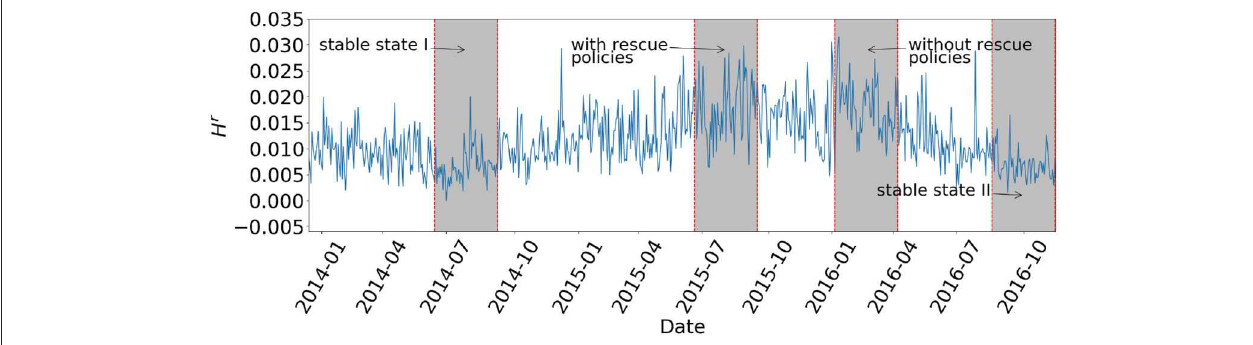
FIGURE 4 | Relative entropy of the stock network for the sampling period from 16 December 2013 to 22 November 2016 in the Shanghai stock